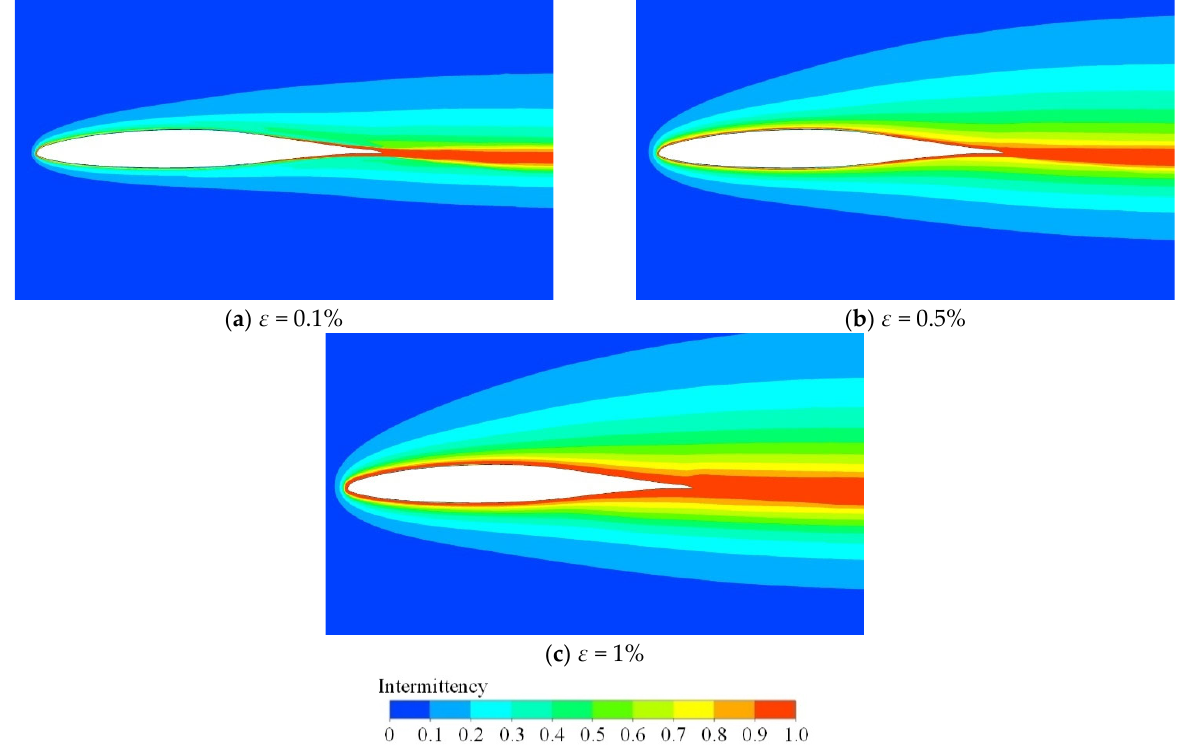
Figure 5. Transition onset locations under various turbulent intensities ( α = 0°, Ma = 0.4). The distribution of intermittency on the midplane of the RAE5243 airfoil under different levels of inflow turbulent intensity is depicted in Figure 6. It can be clearly seen that, with the rise of turbulent intensity, the non-zero region of intermittency gradually expands, and the thickness of the high-intermittency region around the airfoil also increases. This distribution is related the earlier transition onset under higher inflow turbulent intensity.